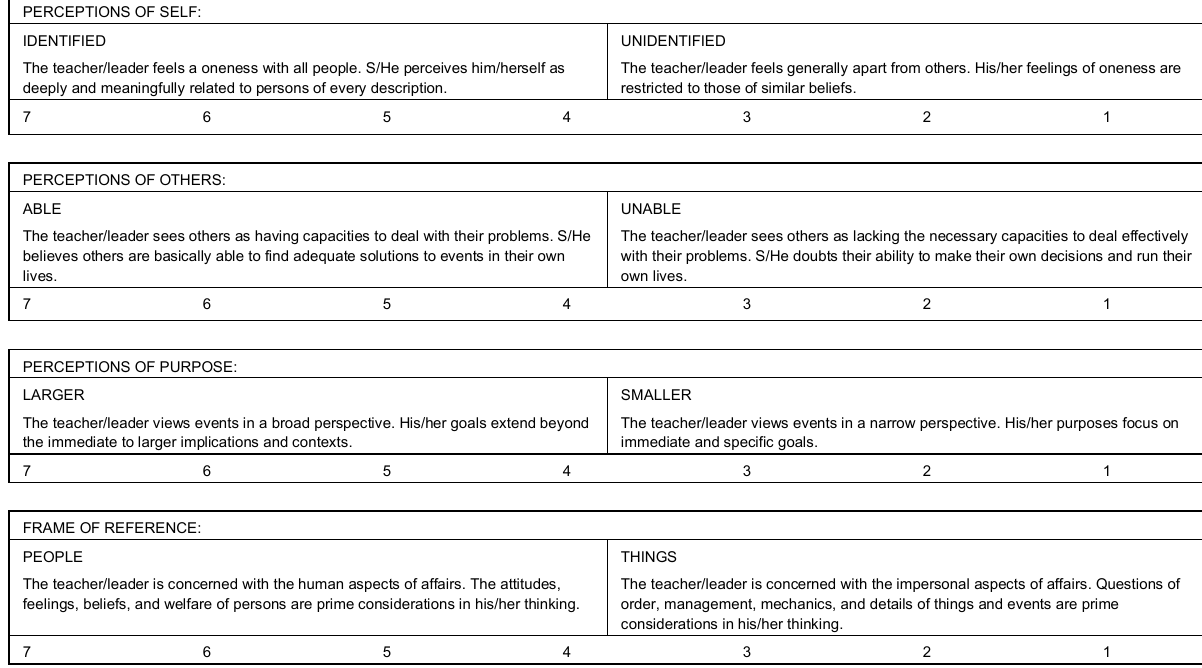
Figure 2. Dispositional Rating